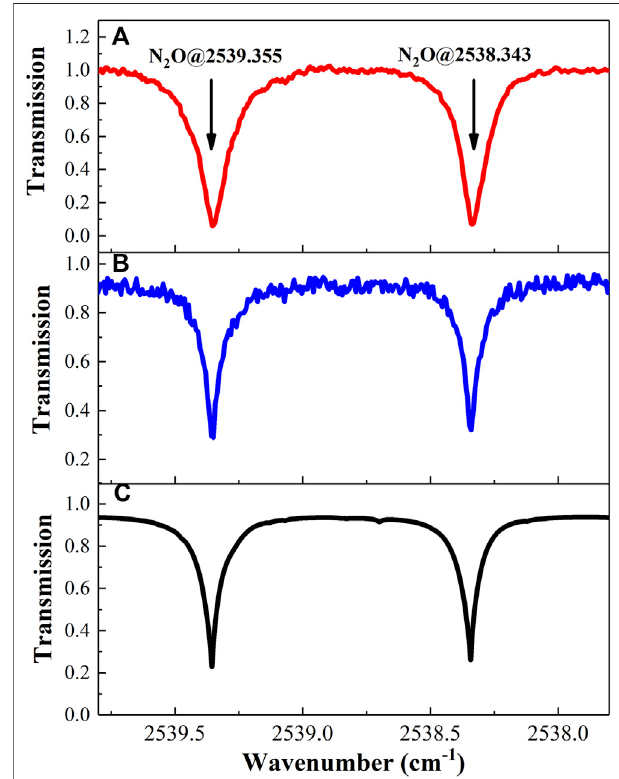
FIGURE 7 | (A) LHR spectrum, (B) FT-IR spectrum, and (C) atmospheric transmission modelling spectrum of N 2 O in the atmospheric